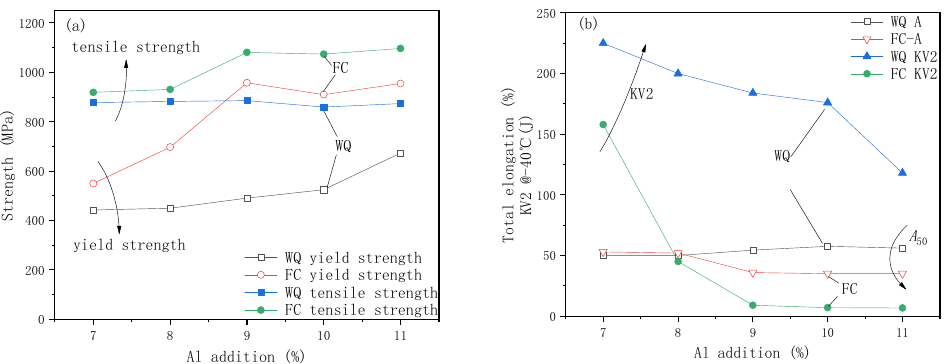
Figure 4. Effect of Al addition on the strength ( a ) and total elongation and Charpy impact absorption properties ( b ).